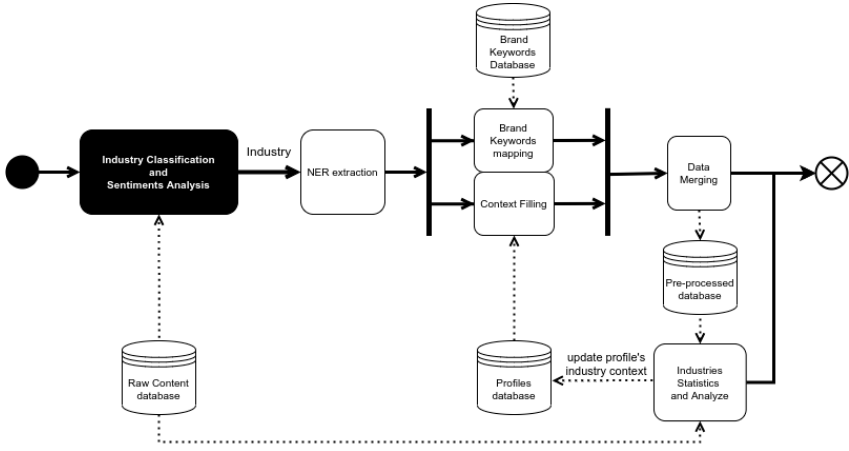
Figure 4. The process for analyzing the sentiment of posts in the ADVO system.